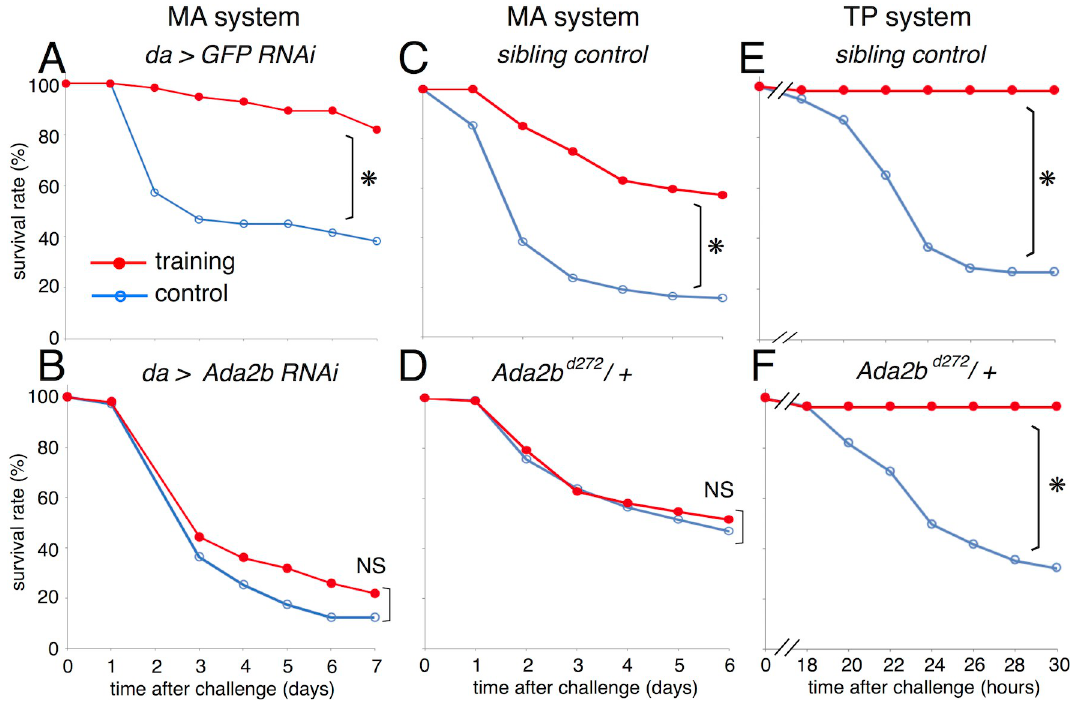
Fig 6. Involvement of Ada2b in Ml-training effects. (A-D) Survival curves of flies under Ml-training and Sa-challenge. (A) Control line (da > GFP RNAi), (B) Ada2b knock down line (da > Ada2b RNAi), (C) Sibling control line ( w ; TM6 / +), (D) Ada2b heterozygotes ( w ; Ada2b d272 / +). (E, F) Survival curves of flies under St-training and Pa-challenge. (E) Sibling control line ( w ; TM6 / +), (F) Ada2b heterozygotes ( w ; Ada2b d272 / +). Pa (OD = 1E-2) was used in these experiments, because these fly lines showed strong resistance against Pa when compared with Oregon-R (Fig 1C). Red and blue lines represent the flies with and without training, respectively. Asterisks and NS indicate statistically significant (p-value < 0.05) and not significant, respectively, in Log-rank test. Numbers of flies used in these experiments are (A) 56, 57 flies / 3 vials, (B) 96, 100 flies / 6 vials, (C) 80, 92 flies / 6 vials, (D) 97, 103 flies / 6 vials, (E) 52, 60 flies / 3 vials, (F) 58, 62 flies / 3 vials (with or without training, respectively).